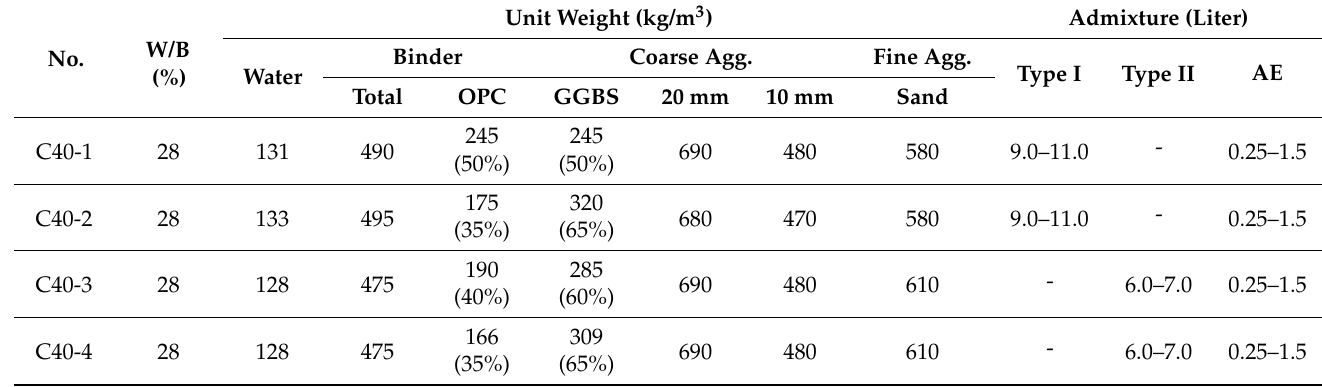
Table 7. Trial mix proportions of cryogenic concrete.